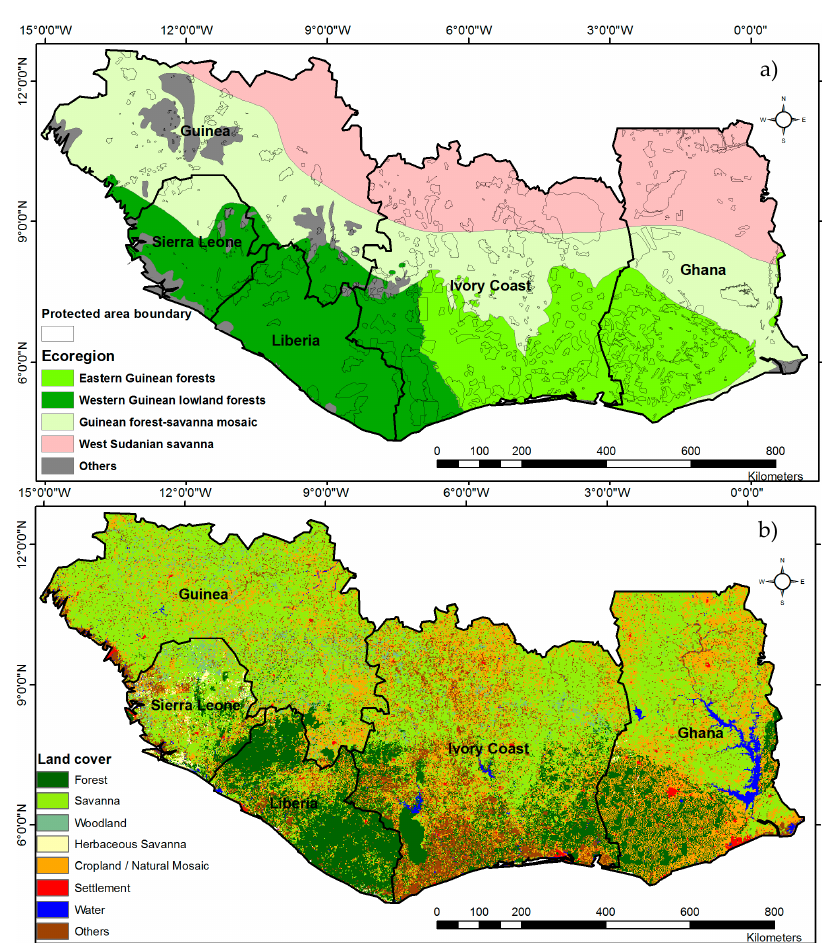
Figure 1. Map of study the area overlaid with: ( a ) terrestrial ecoregions of the world [23]; and ( b ) a 2 km spatial resolution West African land cover/land use map for 2013 developed by the USGS. We aggregated the original cover types into eight general classes.